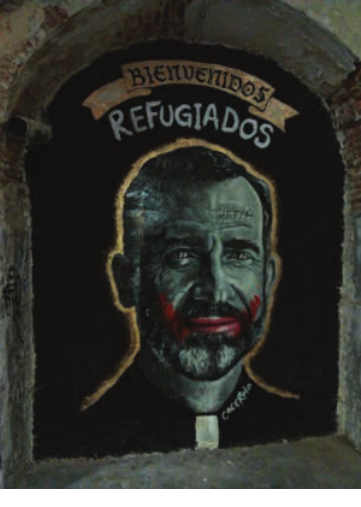
Sample 140 is a graffiti of the current Head of the Spanish State with the Joker’s smile drawn on his face, accompanied by the text: “ Bienvenidos refugiados ” [Welcome Refugees]. Technically, he is a first generation Spaniard, since both his parents were refugees.